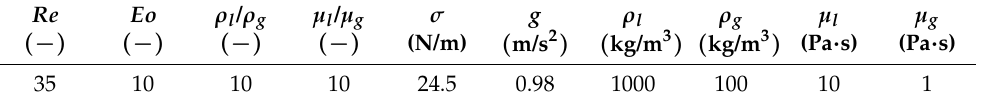
The boundary conditions are: (a) no-slip condition on upper and lower boundaries and (b) free-slip condition on the vertical walls. The numerical domain is discretized by a uniform mesh of 80 × 160 cells. The bubble center-of-mass velocity in the interval between t = 0 s and t = 3 s and the bubble shape at t = 3 s were compared. Figure A2 shows the comparison between the numerical predictions of FT S and VOF S and the benchmark